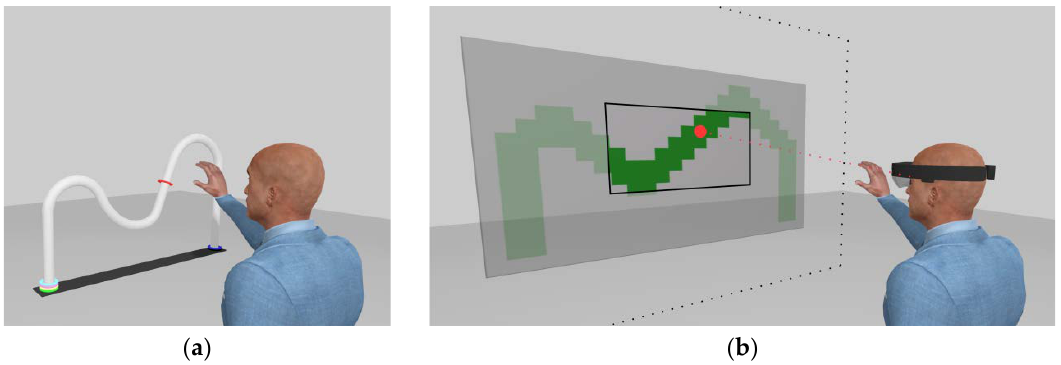
Figure 1. An example of a range of motion (ROM) exercise using the traditional and the artificial reality (AR)-based shoulder rehabilitation: ( a ) ROM exercise using traditional “Rolyan Range of Motion Shoulder Arc”, ( b ) ROM exercise using the AR shoulder rehab app on the Microsoft HoloLens optical see-through head-mounted device (OST-HMD).